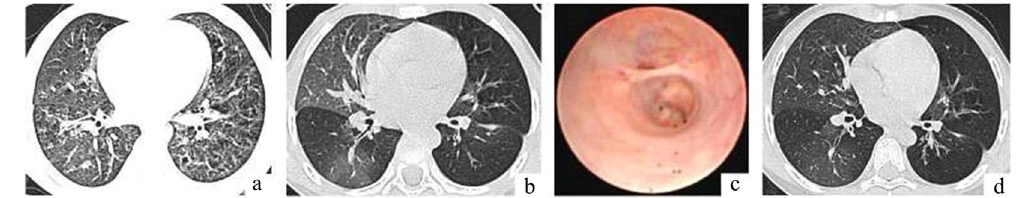
Figure 1. Representative HRCT and Bronchoscopy findings of a patient with moderate disease. ( a ) HRCT showing inflammatory bronchiolitis. ( b ) HRCT showing mosaic patterns, bronchiectasis and left lung hyperlucency. ( c ) Bronchoscopy showing a partially occluded lumen in segmental bronchi. ( d ) HRCT showing BO after 4 years of treatment.